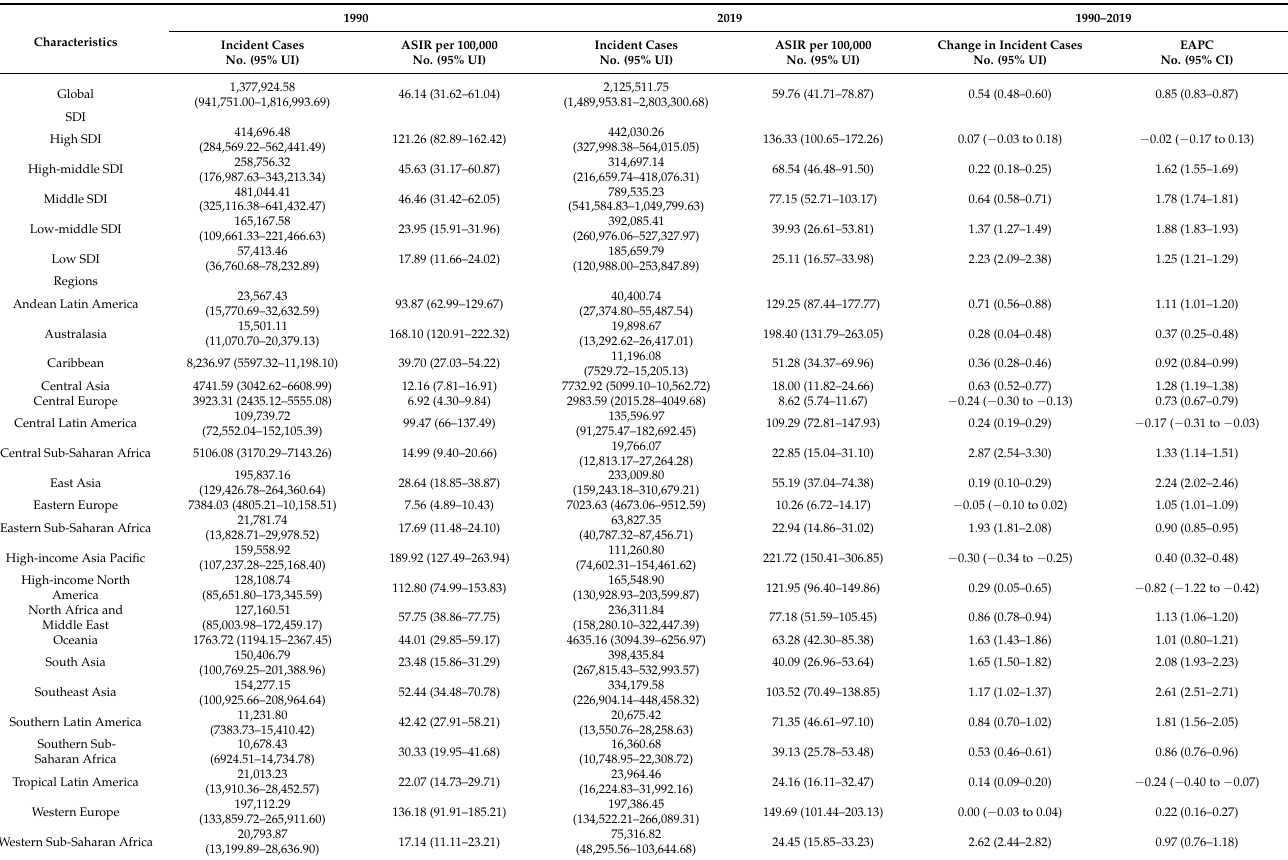
Table 1. The incident cases and ASIR of PCOS at the regional level and its temporal trends from 1990 to 2019.